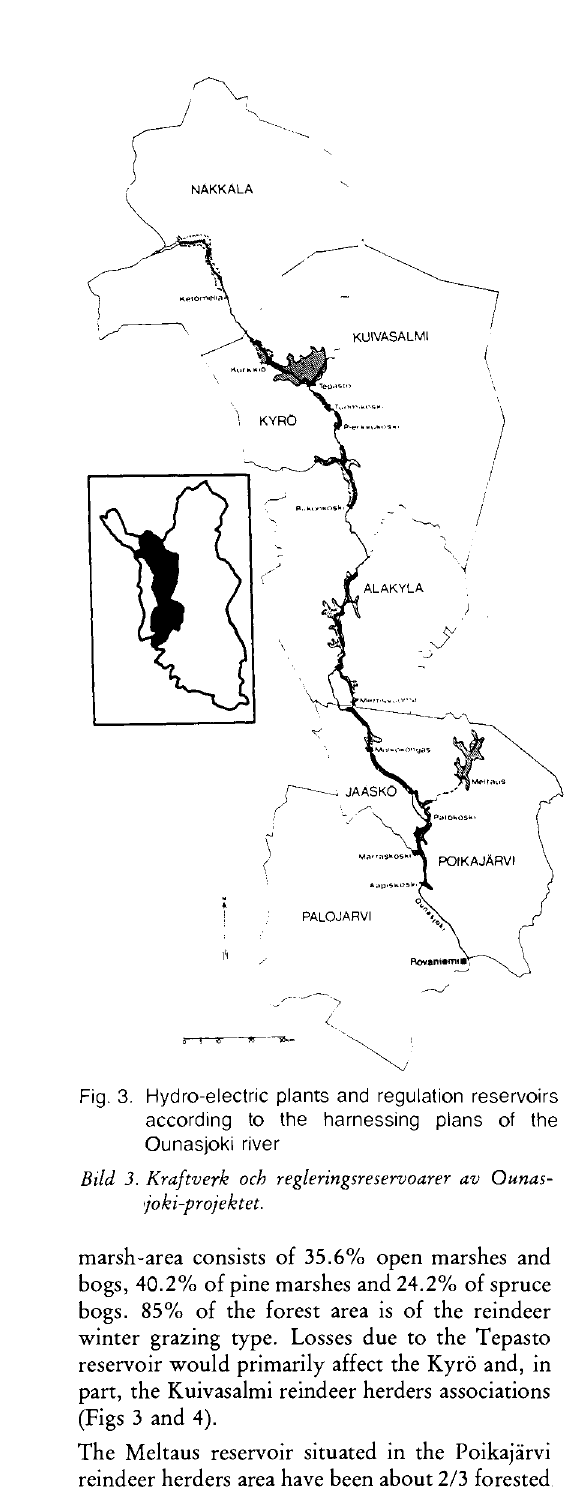
Fig. 3. Hydro-electric plants and regulation reservoirs according to the harnessing plans of the Ounasjoki river Bild 3. Kraftverk och regleringsreservoarer av Ounas- joki-projektet. marsh-area consists of 35.6% open marshes and bogs, 40.2% of pine marshes and 24.2% of spruce bogs. 85% of the forest area is of the reindeer winter grazing type. Losses due to the Tepasto reservoir would primarily affect the Kyro and, in part, the Kuivasalmi reindeer herders associations (Figs 3 and